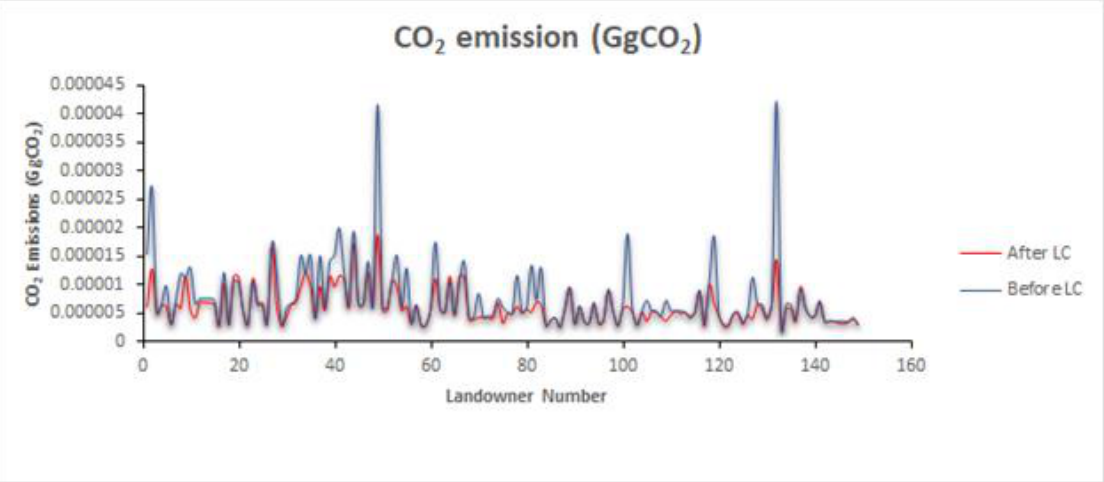
Figure 3. Changes in the carbon footprint values in individual enterprises after land consolidation (Fatih Neighborhood).